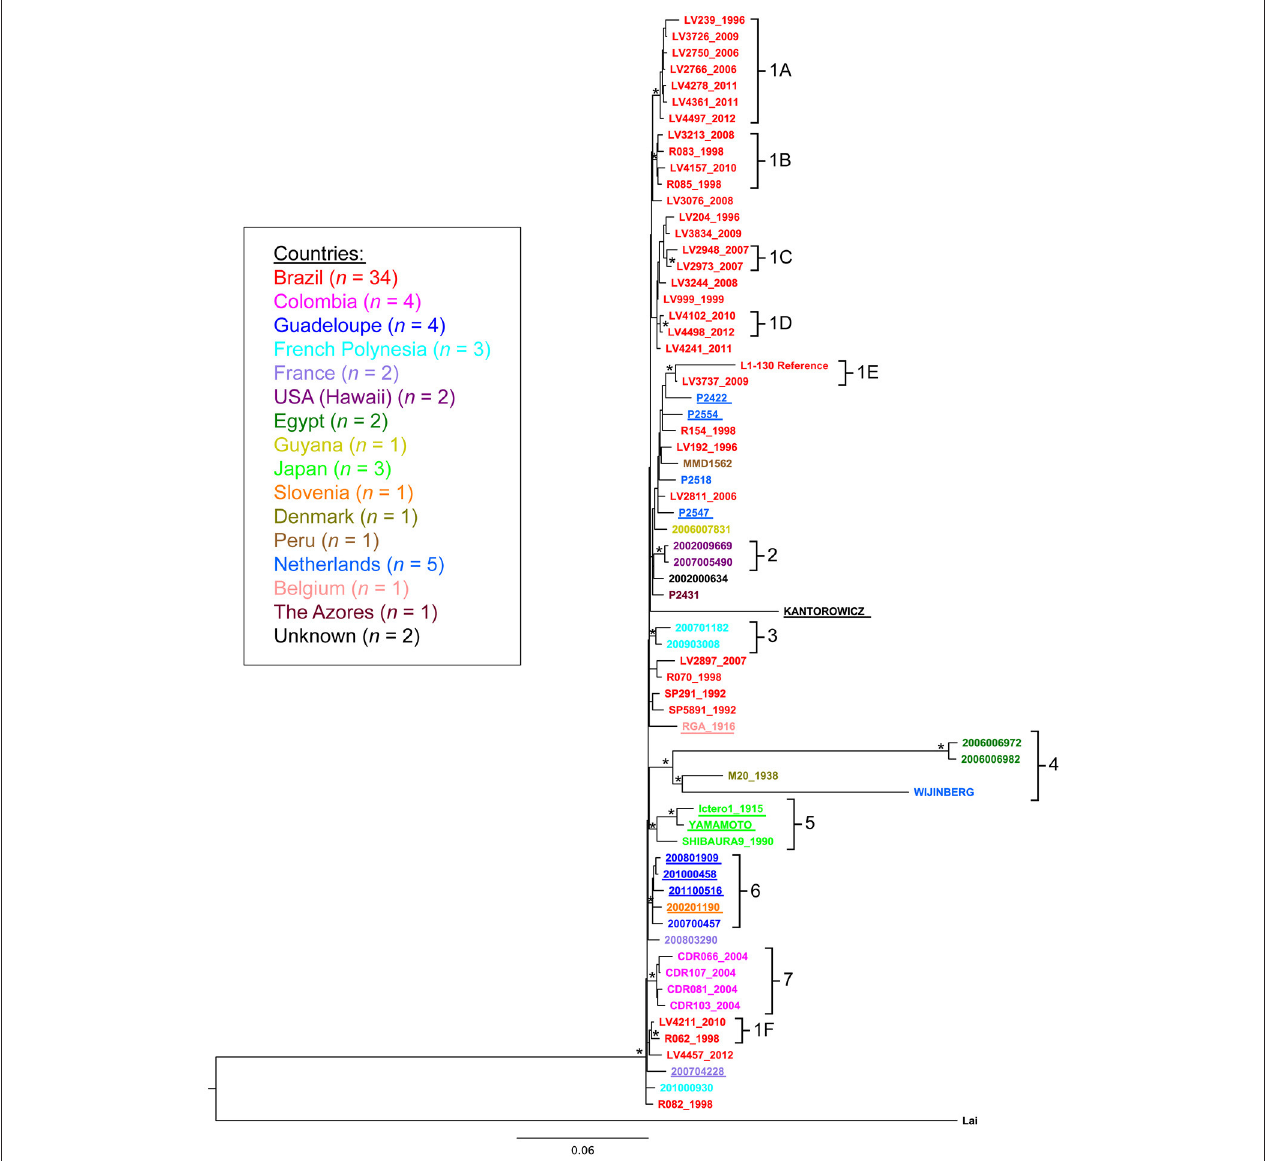
FIGURE 2 | Phylogenetic relationship among Leptospira interrogans serovar Copenhageni and Icterohaemorrhagiae strains. Maximum likelihood tree depicting phylogenetic relationship among Leptospira interrogans serovars Copenhageni and Icterohaemorrhagiae from different geographical locations. Phylogeny constructed using the SNPs sites. Asterisk (*) represents clusters with statistical Bootstrap support higher than 70%. The sequences from serovar Icterohaemorrhagiae are underlined. L. interrogans serovar Lai was used as an outgroup for this analysis. The strain sequences are colored by country of isolation following the legend. The clusters numbers are related to country of isolation: 1A − 1F (Brazil), 2 (Hawaii, US), 3 (French Polynesia), 4 (Egypt, Netherlands and Denmark), 5 (Japan), 6 (Guadalupe and Slovenia), and 7